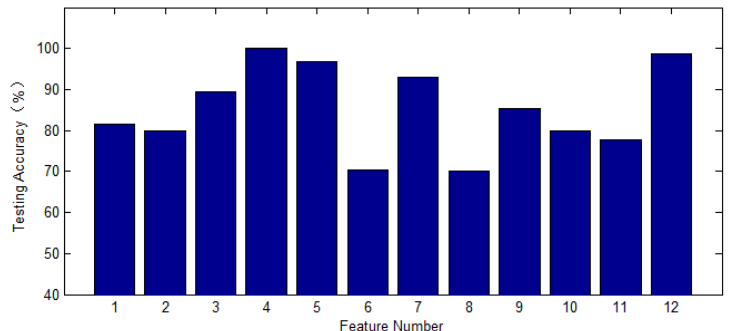
Figure 17. Diagnosis result of fault severity of ball under different features. 1: Ma ; 2: Mi ; 3: P k ; 4: A v ;